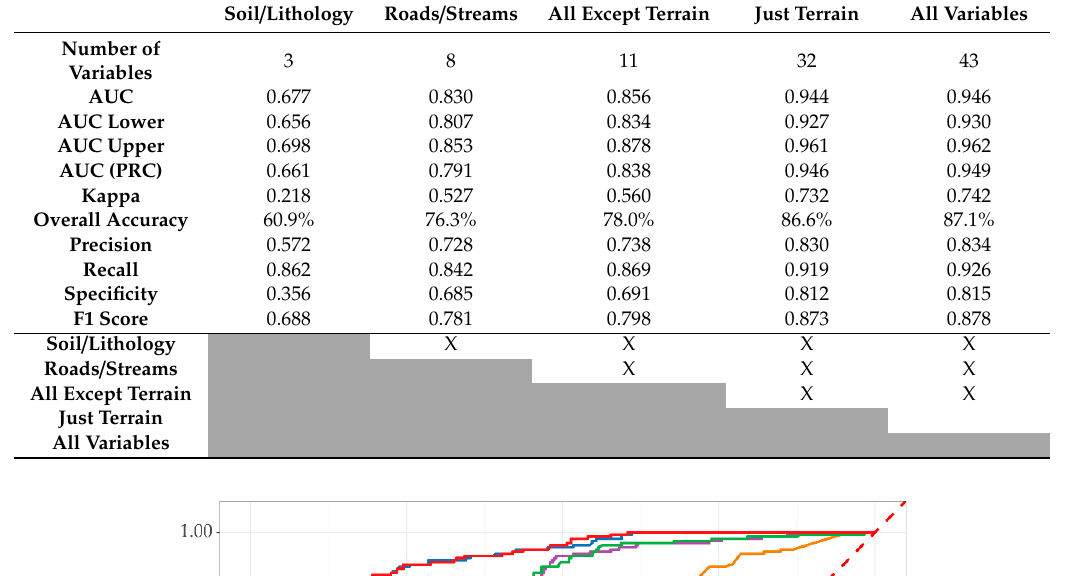
Table 6. Comparison for di ff erent feature spaces. Lower and upper bounds represent a 95% confidence interval calculated using 2000 stratified bootstrap replicates. X indicates statistically significantly di ff erent receiver operating characteristic (ROC) curves at a 95% confidence level.